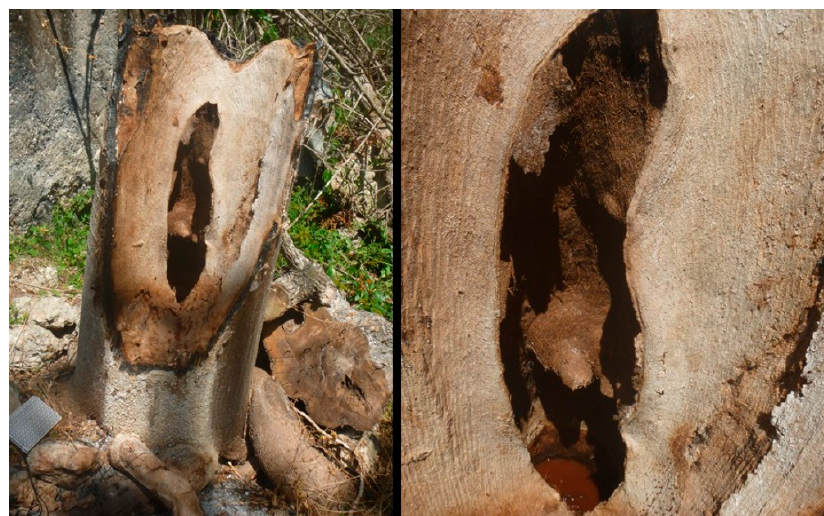
Figure 10. Stump of Ceiba pentandra ( left ) showing the water-filled rot hole ( left and right ) where larvae of Meromacrus yucatense sp. nov. were found (Photo: Javier Quinto).